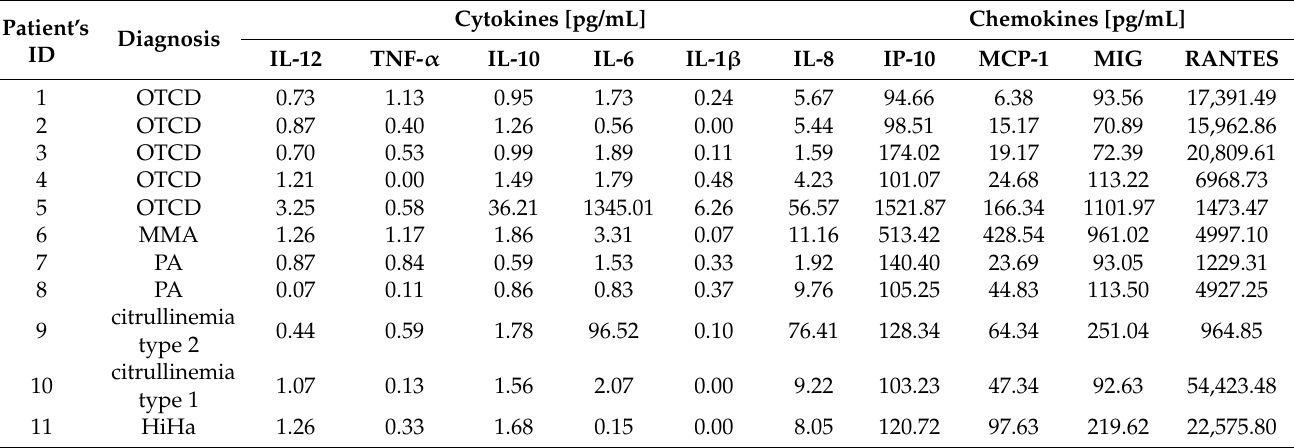
Table 3. S100B, 3-nitrotyrosine, AOPP concentration, and GPx activity in plasma 1 .